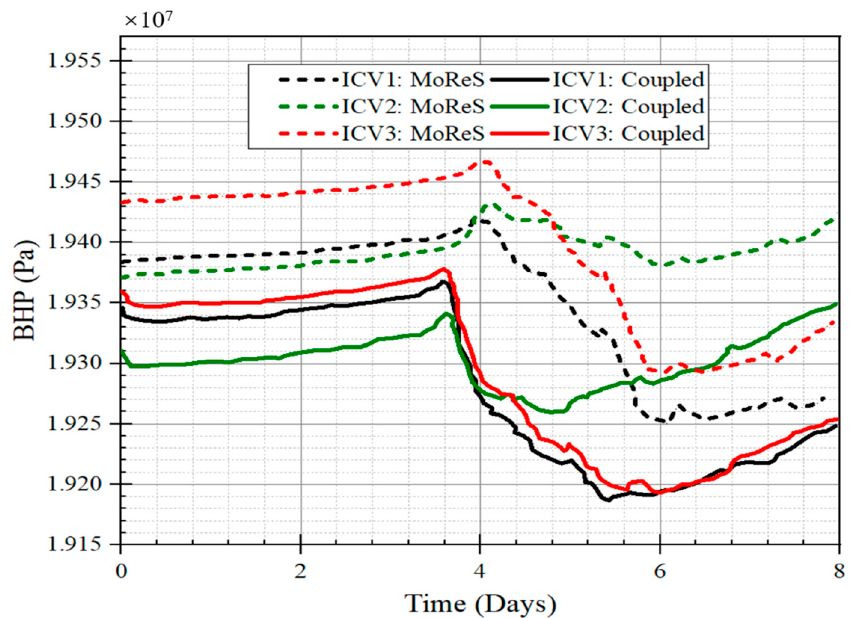
Figure 7. BHP at different ICVs versus time during gas breakthrough. This figure was modified from Figure 7 in ref [4]. Figure 7 in ref